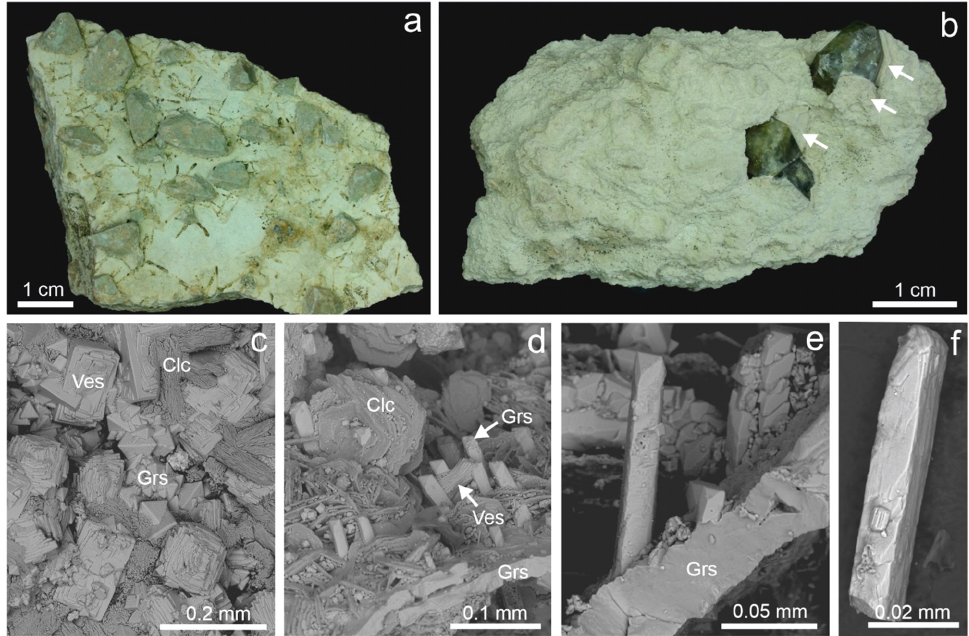
Figure 1. ( a ) “Achtarandite” crystals on the surface of a grossular–diopside–chlorite rodingite-like rock with an admixture of minerals of the kaolinite–serpentine group; ( b ) grossular crystals with epitaxial overgrowths of “achtarandite” (arrows) in rodingite-like rock; ( c , d ) minerals of the internal part of sponge achtarandite pseudomorphs, BSE; ( c ) splitting (H 4 O 4 ) 4 − -substituted, B-bearing vesuvianite crystals and octahedral grossular-katoite crystals; ( d ) short-prismatic crystals of hydrogrossular; ( e ) long-prismatic hydrogrossular crystal elongated along [110]; ( f ) prismatic hydrogarnet crystal elongated along the [111] direction used for the single-crystal X-ray diffraction study.